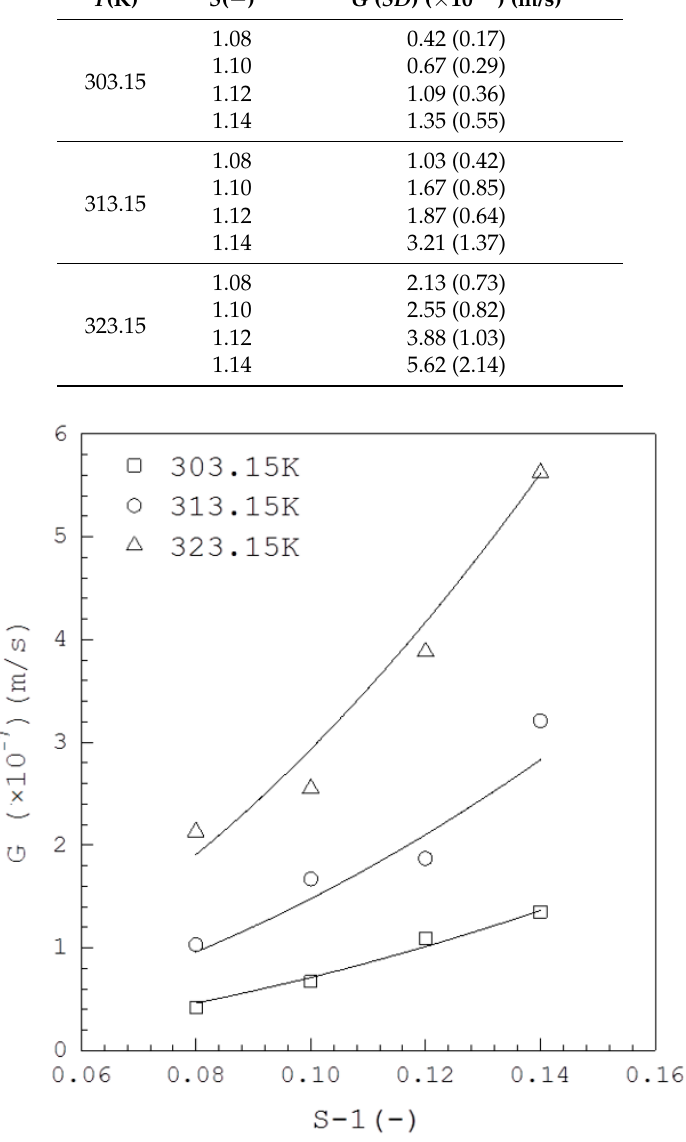
Figure 8. The growth rate data of L-glycine for various supersaturations at 303.15–323.15 K. The lines represent the fitted values to Equation (13) using g = 2, E G = 57 kJ/mol and A G = 6.05 × 10 4 m/s . Table 5. The average growth rates and the corresponding standard deviations (SD) for L-Glycine. 𝑻(𝐊) 𝑺(−) 𝑮 (𝑺𝑫) (× 𝟏𝟎 (cid:2879)𝟕 ) (𝐦/𝐬)